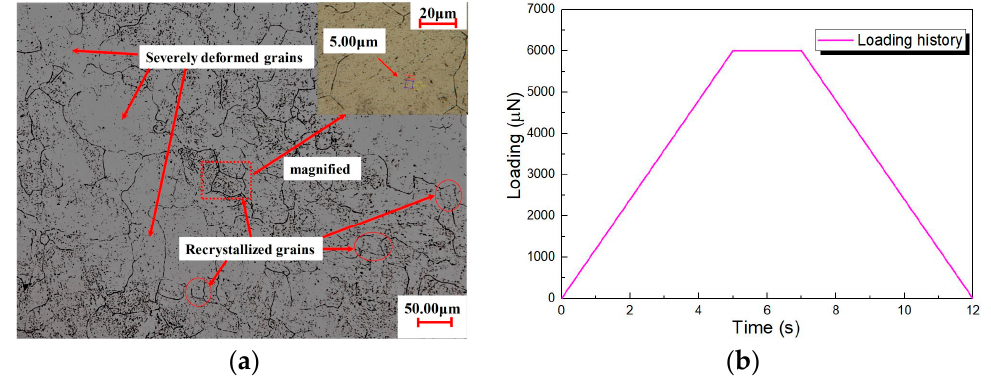
Figure 2. Locations and parameters of nanoindentation tests: ( a ) examples of indentation locations including the interiors of deformed grains and recrystallized grains; ( b ) loading history of nanoindentation tests.